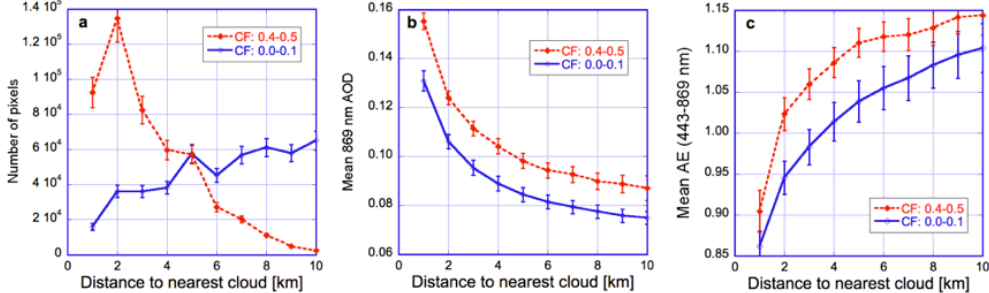
Figure 10. Impact of distance to cloud for two cloud fraction (CF) ranges. ( a ) Number of pixels; ( b ) aerosol optical depth; ( c ) Angstrom exponent. The data is plotted for the region and time period examined in Figures 2, 3 and 5. The error bars indicate the uncertainties due to interannual variability, estimated from the spread of results for individual years. Similar to the blue curves in Figure 2, all QA flags are used to screen the data except for the STRL and SSTW flags. The figure is based on Figure 6 of [50].